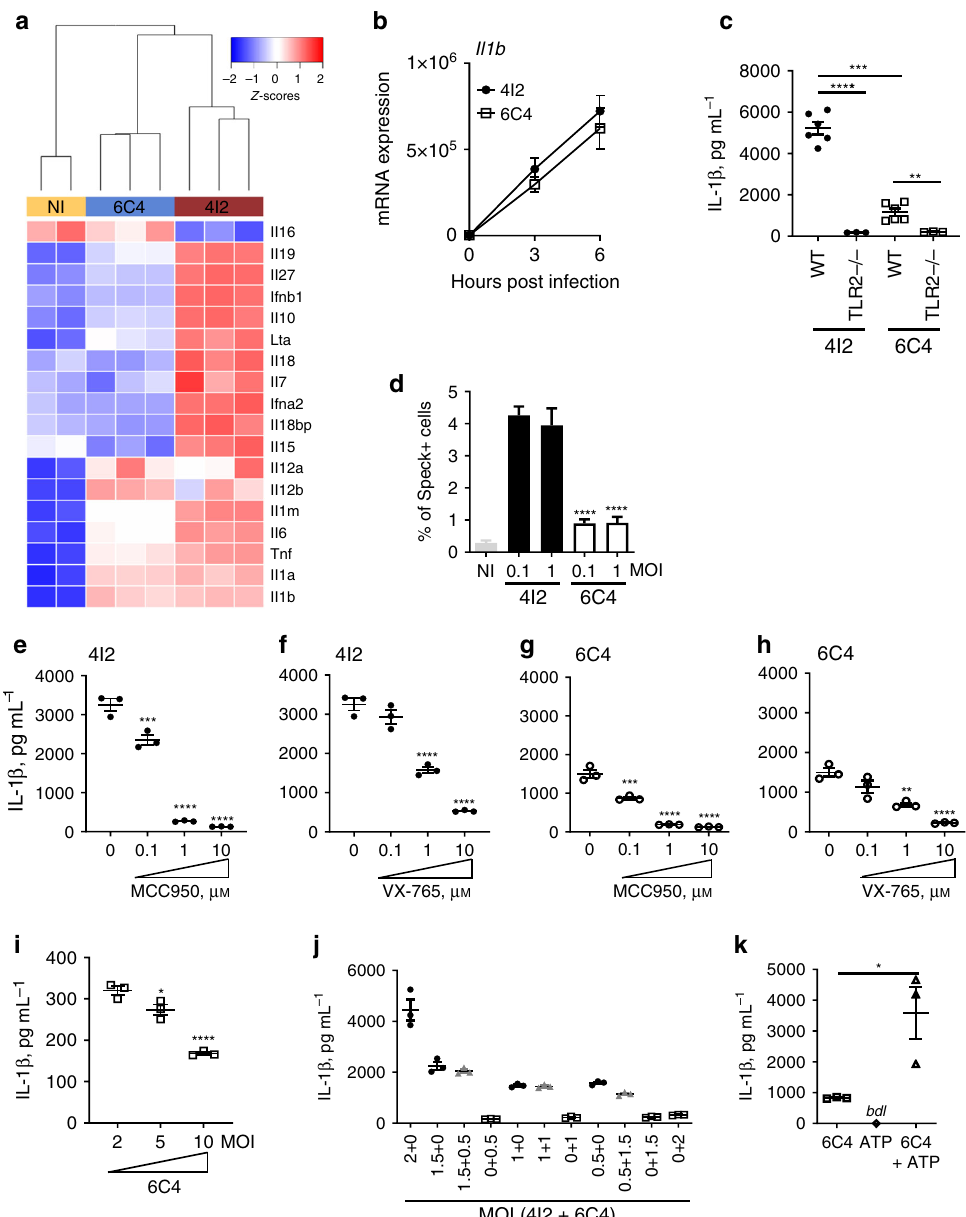
Fig. 5 Induction of high IL-1 β by M . tuberculosis 4I2 results from enhanced in fl ammasome activation. a Gene expression heatmap representing cytokine expression for non-infected BMDMs (NI, yellow) and BMDMs infected with M . tuberculosis isolate 4I2 (dark red) or M . tuberculosis isolate 6C4 (blue). z - scores are color coded as shown. b C57BL/6 WT BMDMs were generated and infected with M . tuberculosis isolates 4I2 (solid circles) or 6C4 (open squares), and at the indicated time points, the cell cultures were lysed, RNA extracted, converted to cDNA and subjected to real-time PCR. c C57BL/6 WT or TLR2 de fi cient BMDMs were generated and infected with M . tuberculosis isolates 4I2 (solid circles) or 6C4 (open squares). Twenty-four hours post- infection the culture supernatants were harvested and the amount of IL-1 β quanti fi ed by ELISA. d THP-1-ASC-GFP monocytes were PMA-differentiated and left uninfected (NI) or infected with M . tuberculosis isolates 4I2 (solid bars) or 6C4 (open bars) at different MOI, as indicated. Six hours post-infection, cells were fi xed and stained with DAPI prior to image acquisition. The percentage of Speck-positive cells was determined for the different conditions. C57BL/6 WT BMDMs were generated and infected with M . tuberculosis isolates 4I2 ( e , f ) or 6C4 ( g , h ) in the absence (0) or presence of increasing doses of NLRP3 (MCC950; e , g ) or Caspase-1 (VX-765; f , h ) inhibitors. BMDMs were infected with increasing MOI of M . tuberculosis isolate 6C4 (I), with a combination of both isolates at different doses ( j ) or with M . tuberculosis isolate 6C4 in the absence (6C4) or presence (6C4 + ATP) of 5 mM of ATP ( k ). e – k Twenty-four hours post-infection the culture supernatants were harvested and the amount of IL-1 β quanti fi ed by ELISA. Unless indicated, an MOI of 2 was used for infections. Represented is the mean ± SEM of triplicate wells for one experiment representative of two ( b – j ); or for one experiment ( k ). Statistical analysis was performed using two-tailed unpaired Student ’ s t -test ( c , k ) or One-way ANOVA ( d – i ) (* p < 0.05; ** p < 0.01; *** p < 0.001; and **** p <